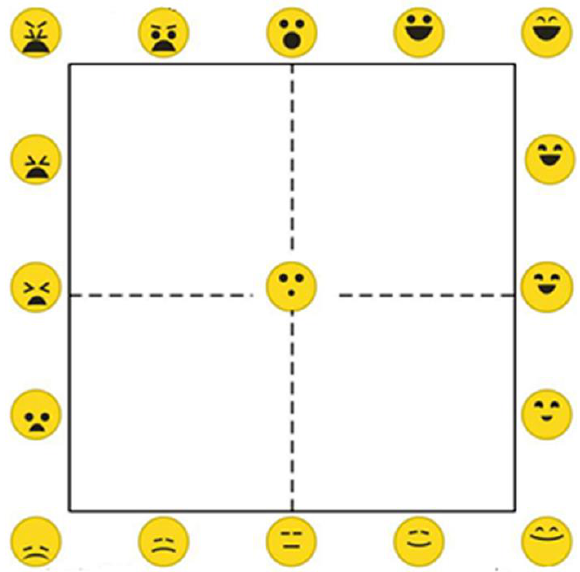
Figure 1. The EmojiGrid used in the study to measure valence and arousal [25].